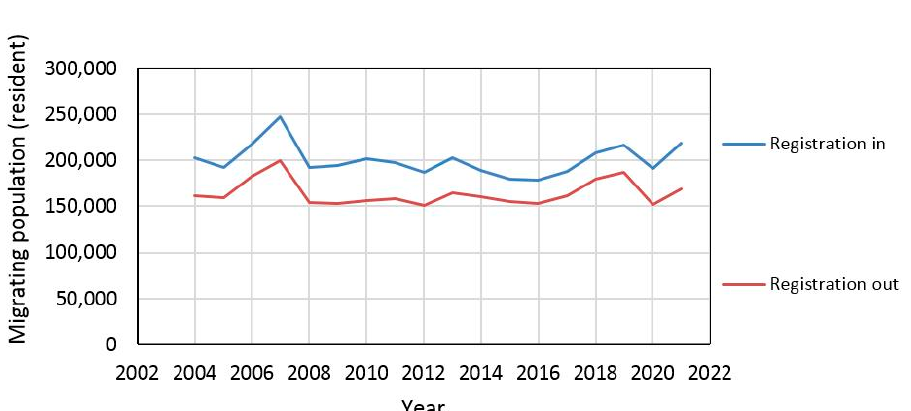
Figure 13. Annual registered migrations to and from rural settlements in Poland in 2004–2021, data obtained from [66].